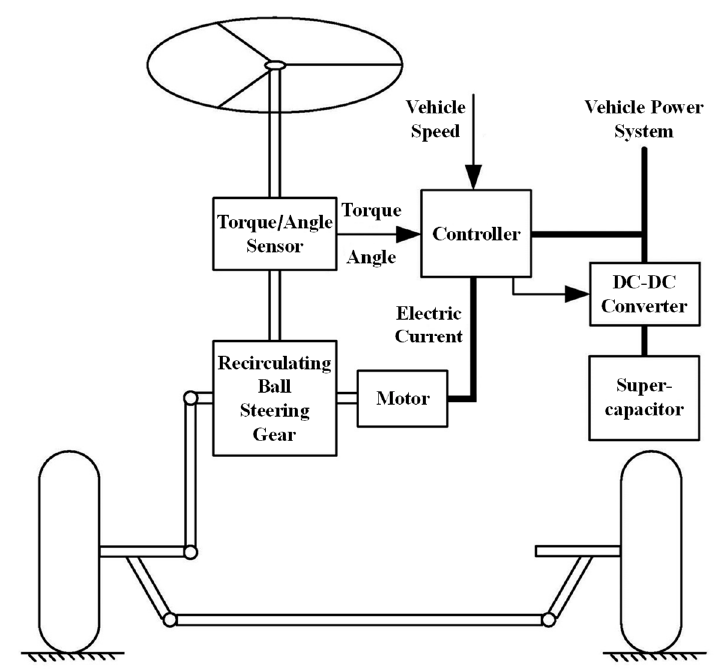
Figure 1. Structure of the SC-EPS system.